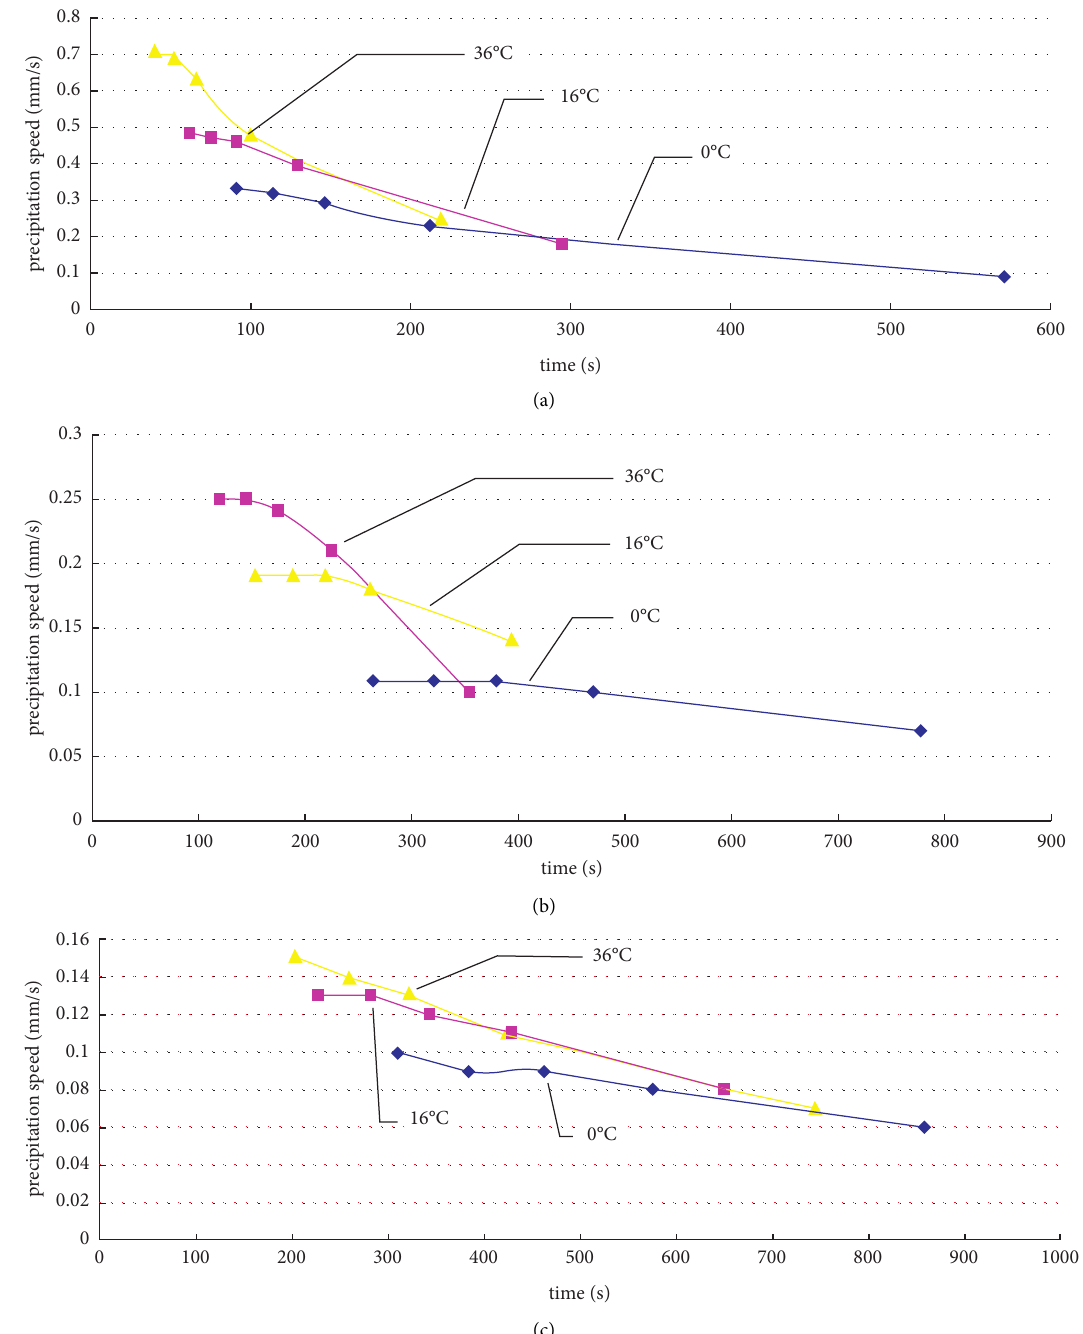
Figure 8: Precipitation speed change curve of the slurries at different temperatures and different aggregates: (a) variation curve of precipitation rate of fly ash slurry under different temperature conditions, (b) variation curve of mixed slurry precipitation speed at the same temperature, and (c) variation curve of clay slurry precipitation rate at different